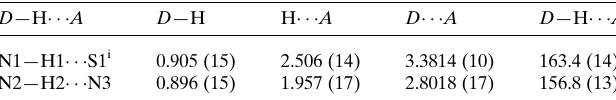
Table 2 Hydrogen-bond geometry (A˚ , (cid:4) ) for 2 .